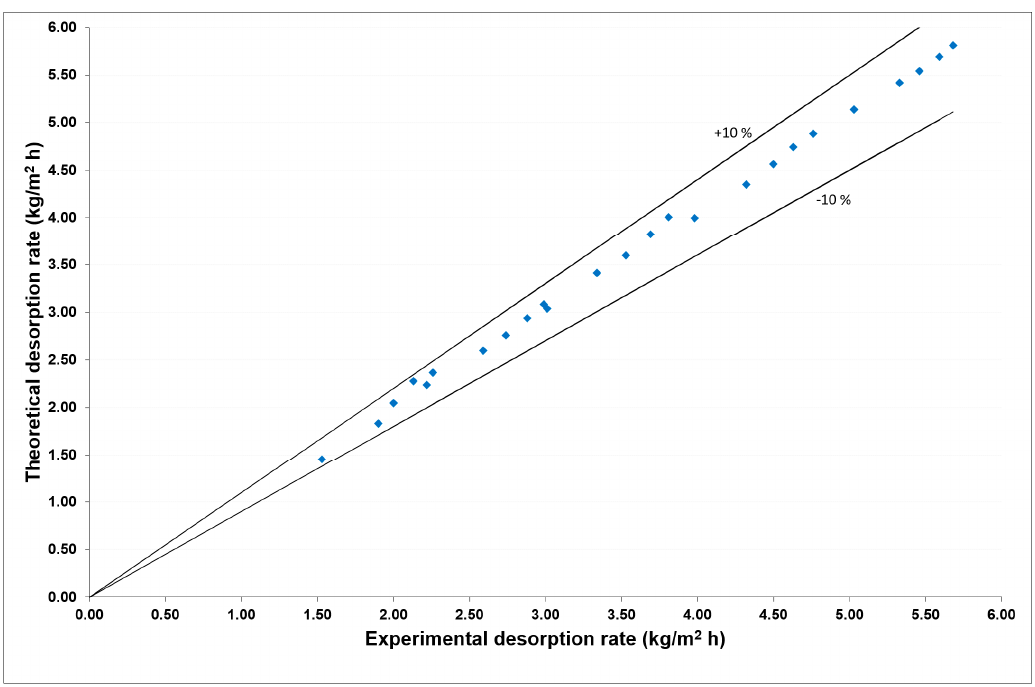
Figure 4. Desorption rate as a function of LiBr solution and cooling water temperatures.